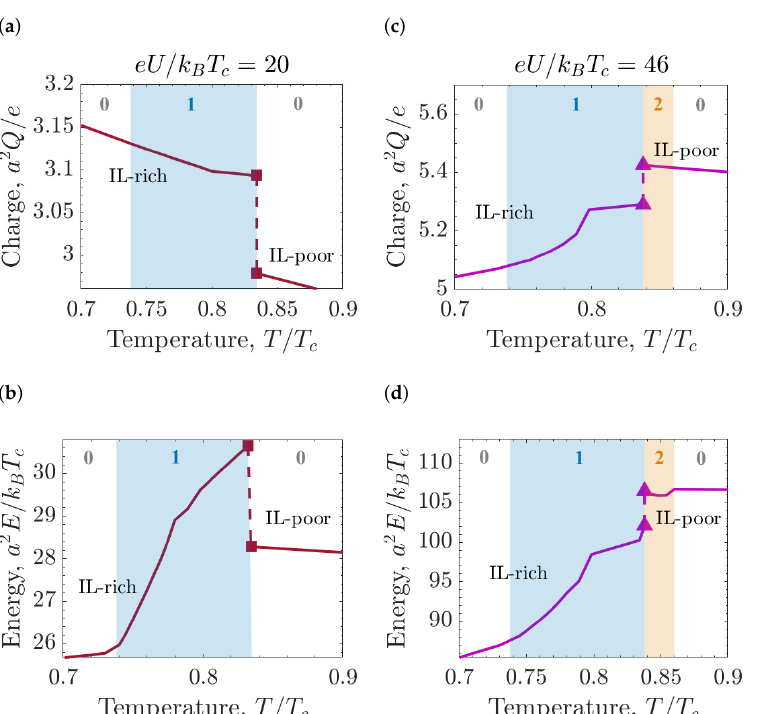
Figure 10. Accumulated charge and stored energy in slit mesopores. ( a ) Accumulated charge for applied voltage eU / k B T c = 20. ( b ) Stored energy for applied voltage eU / k B T c = 20. ( c ) Accumulated charge for applied voltage eU / k B T c = 46. ( d ) Stored energy for applied voltage eU / k B T c = 46. In all the panels, chemical potential µ / k B T c = − 4.57, slit width w = 20 a and ionophilicity a 3 h s / ξ 0 = 0.25, where ξ 0 is the bare correlation length and a the ion